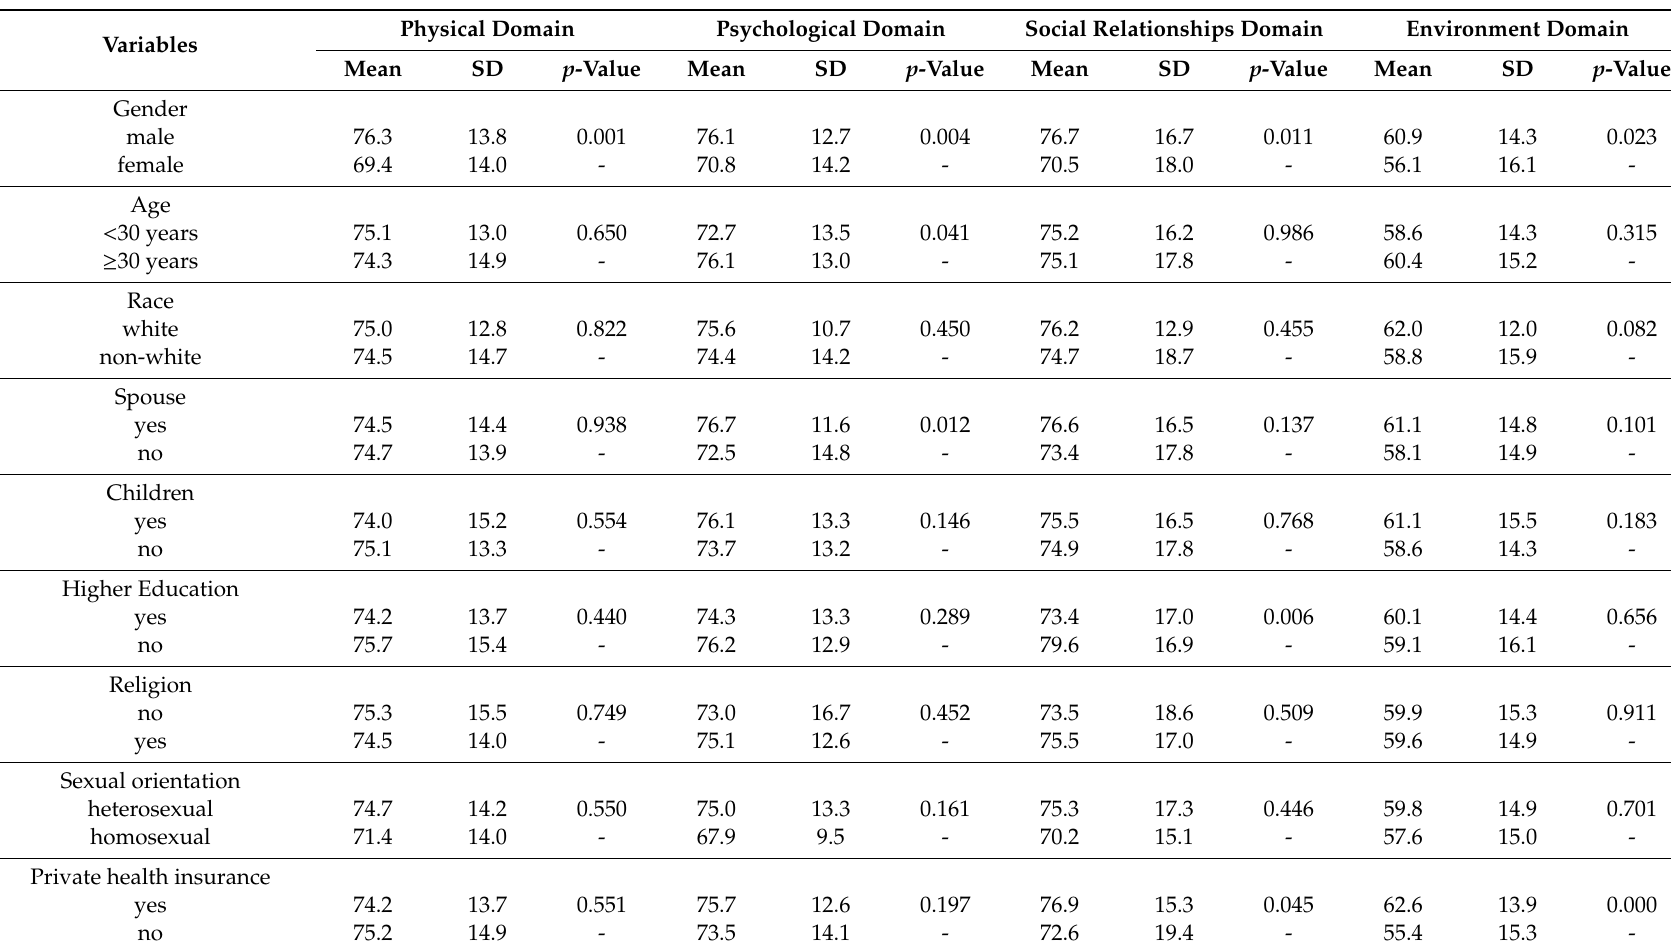
Table 4. Factors potentially associated with the World Health Organization Quality of Life abbreviated version (WHOQOL-BREF) domains among prison o ffi cers.